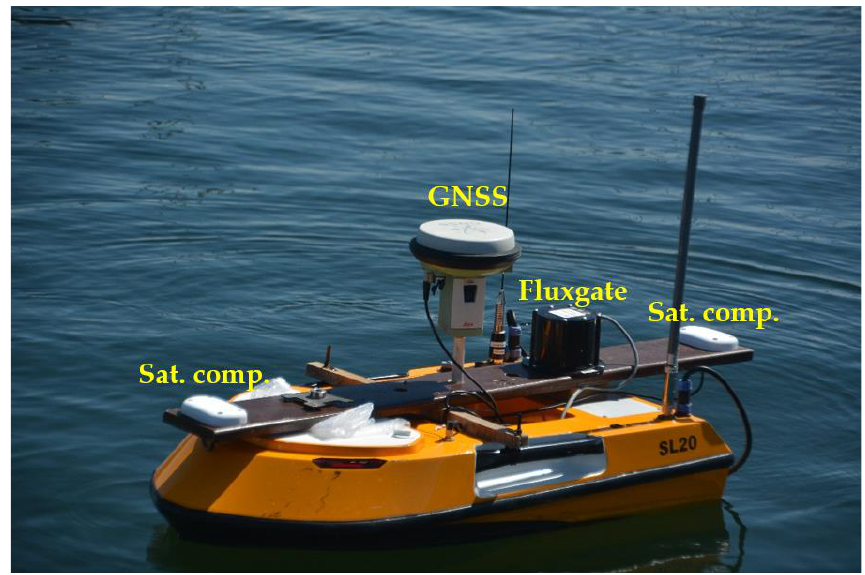
Figure 3. OceanAlpha USV SL20 during multi-sensor heading and course